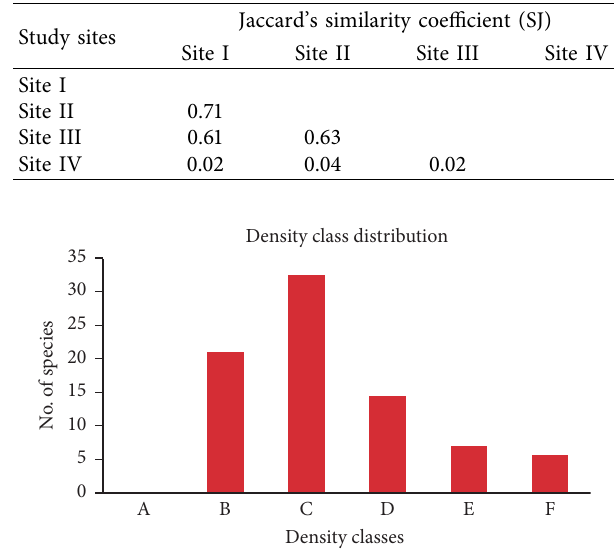
Figure 5: Density class distribution of woody species in MFBR.